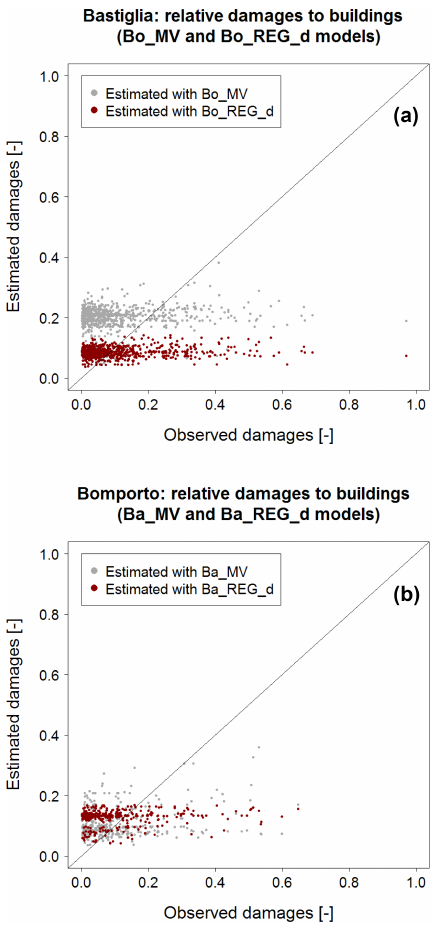
Figure 9. (a) Bastiglia relative damages to buildings estimated with Bo_REG d (red dots) and Bo_MV (grey dots); (b) Bomporto rela- tive damages to buildings estimated with Ba_REG d (red dots) and Ba_MV (grey